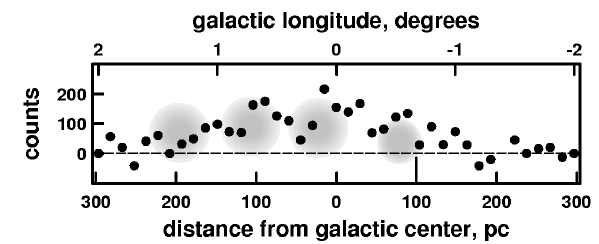
Figure 4: Positions of the molecular clouds and the number of TeV gamma rays observed by the HESS ex- periment (Aharonian et al,